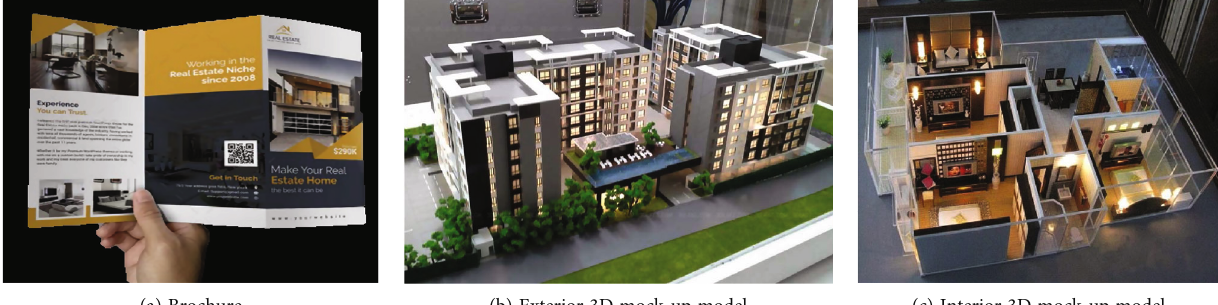
Figure 1: Common promotion tool in housing sector.